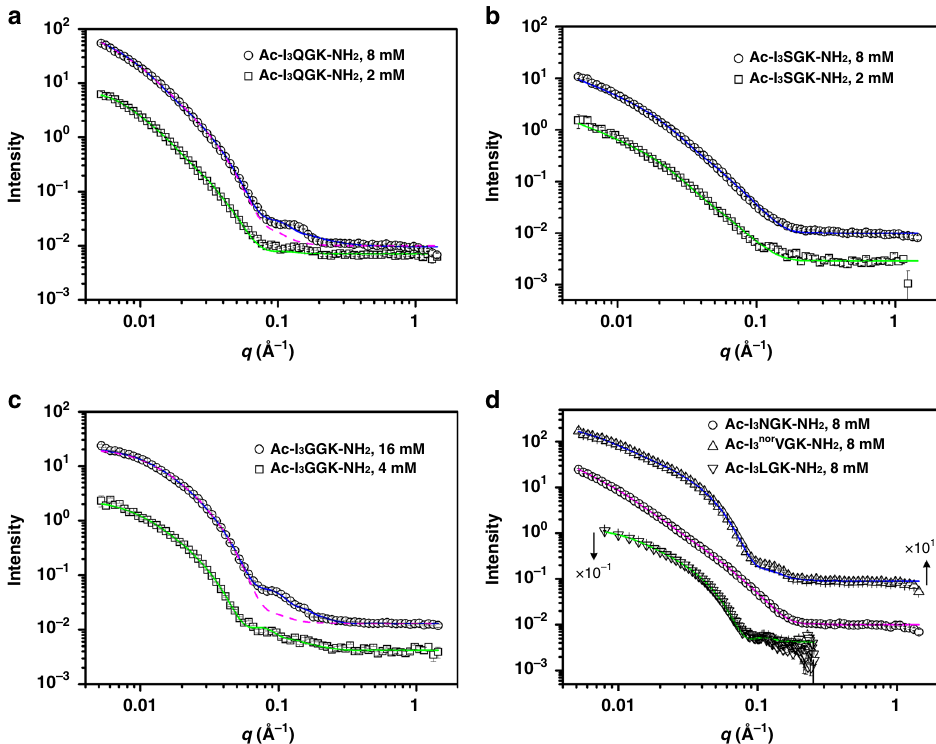
Fig. 3 SANS data and fi tted pro fi les. a Ac-I 3 QGK-NH 2 . b Ac-I 3 SGK-NH 2 . c Ac-I 3 GGK-NH 2 . d Ac-I 3 NGK-NH 2 , Ac-I 3 nor VG-NH 2 , and Ac-I 3 LGK-NH 2 . The error bars are also shown, but in most cases, they are hidden within the symbols. For clarity, the signals of Ac-I 3 nor VG-NH 2 in ( d ) have been vertically displaced by a factor of × 10 1 , whereas those of Ac-I 3 LGK-NH 2 by a factor of × 10 − 1 . The SANS data of Ac-I 3 LGK-NH 2 were recorded on the LOQ diffractometer which has a narrower q range while those for the other peptides were obtained on the SANS2D diffractometer. The lines are the best fi ts to the models with parameters given in Table 1, and Supplementary Tables 1 and 2. Note that for 8 mM Ac-I 3 QGK-NH 2 and 16 or 4 mM Ac-I 3 GGK-NH 2 , the combination of two ECM models or two FCM models, respectively, can fi t the SANS data much better (solid lines). The dashed lines represent the best fi ts to a single ECM model and a single FCM model for 8 mM Ac-I 3 QGK-NH 2 and 16 mM Ac-I 3 GGK-NH 2 , respectively